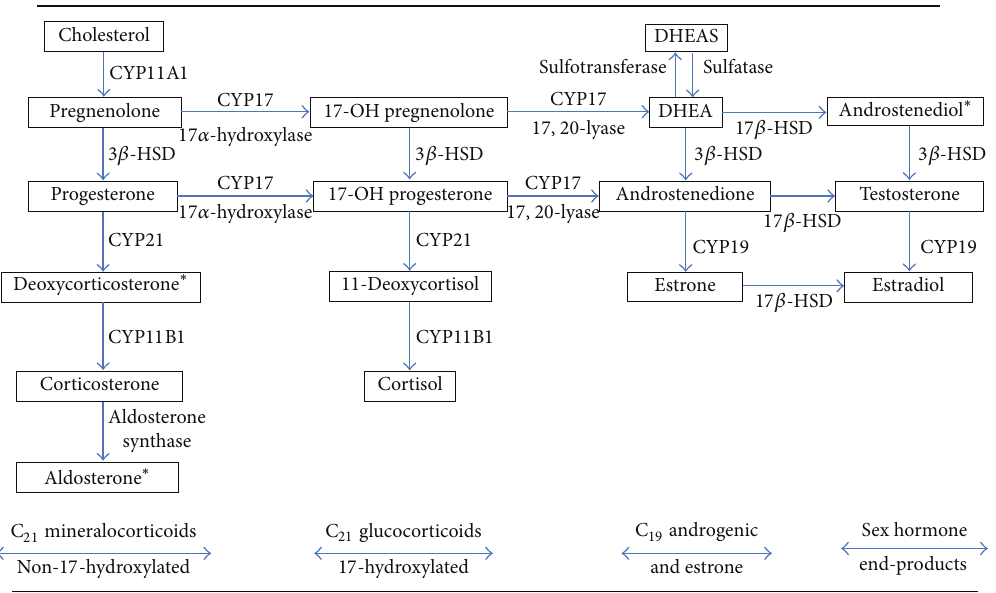
Figure 1: A simplified schema of the major adrenal and sex steroids, emphasizing the biosynthetic pathways leading to mineralocorticoids, glucocorticoids, adrenal androgens (AAs), and sex steroids. Initial conversion from cholesterol to pregnenolone is acutely controlled by ACTH, which chronically activates genes promoting other enzymes in the biosynthetic steps. The adrenal cortical volume increases during pre-pubertal adrenarche until young adulthood, particularly in the zona reticularis (ZR), along with its greater AA production, including DHEA, DHEAS, and androstenedione. Individual variability occurs in serum DHEAS levels, being lower in adult females than males, particularly after menopause (adrenopause). Serum AAs progressively decline with aging and are presumably accompanied by diminishing ZR mass. To the contrary, cortisol is derived from the zona fasciculata (ZF) and its levels remain stable over the ages, as does the ZF mass.